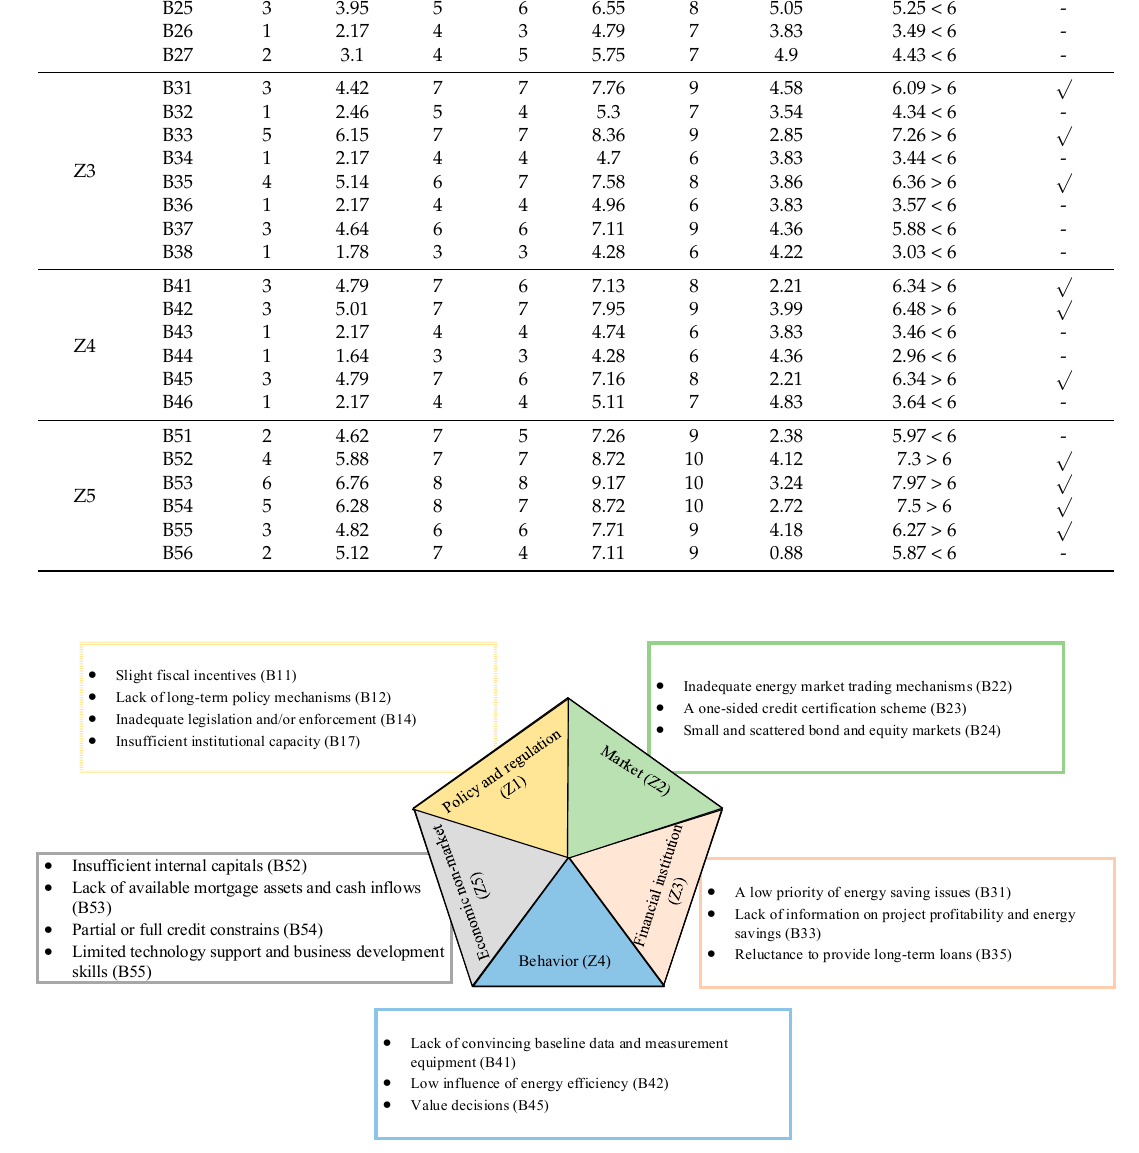
Figure 3. The final evaluation system of identifying key energy efficiency financing barriers for SMEs.